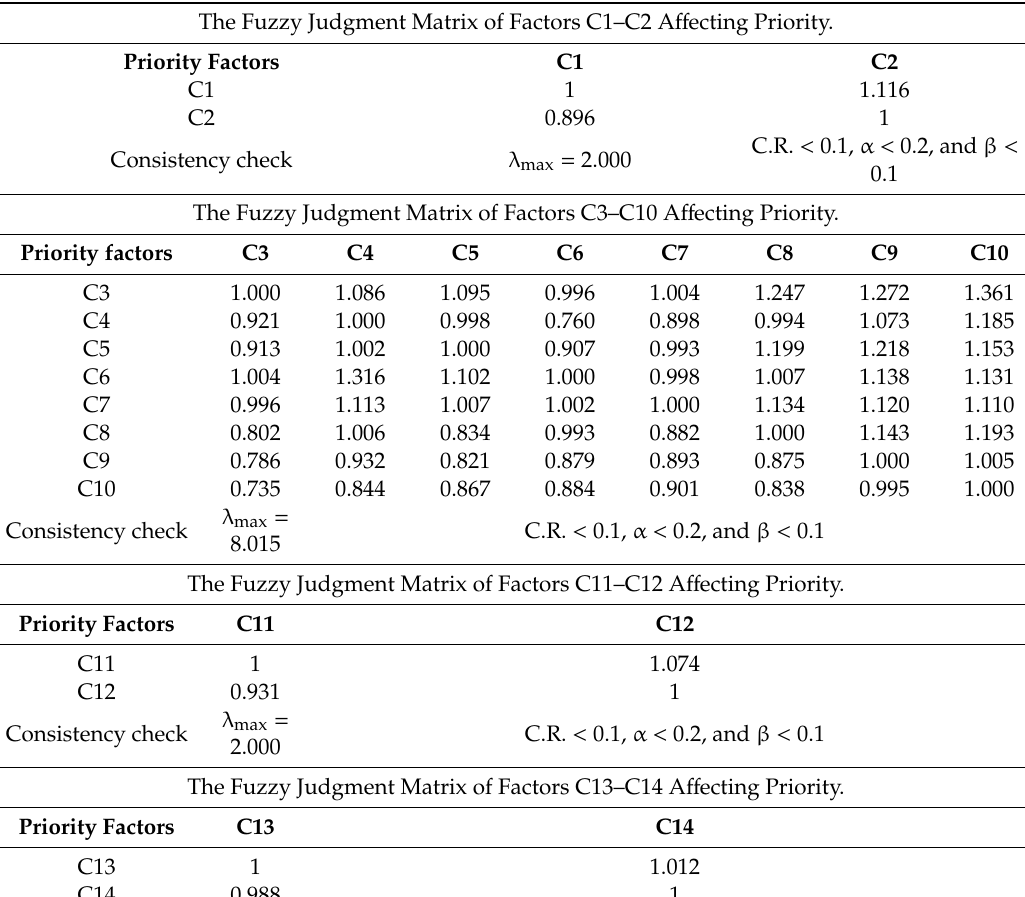
Table A3. The fuzzy judgment Matrix of factors a ff ecting